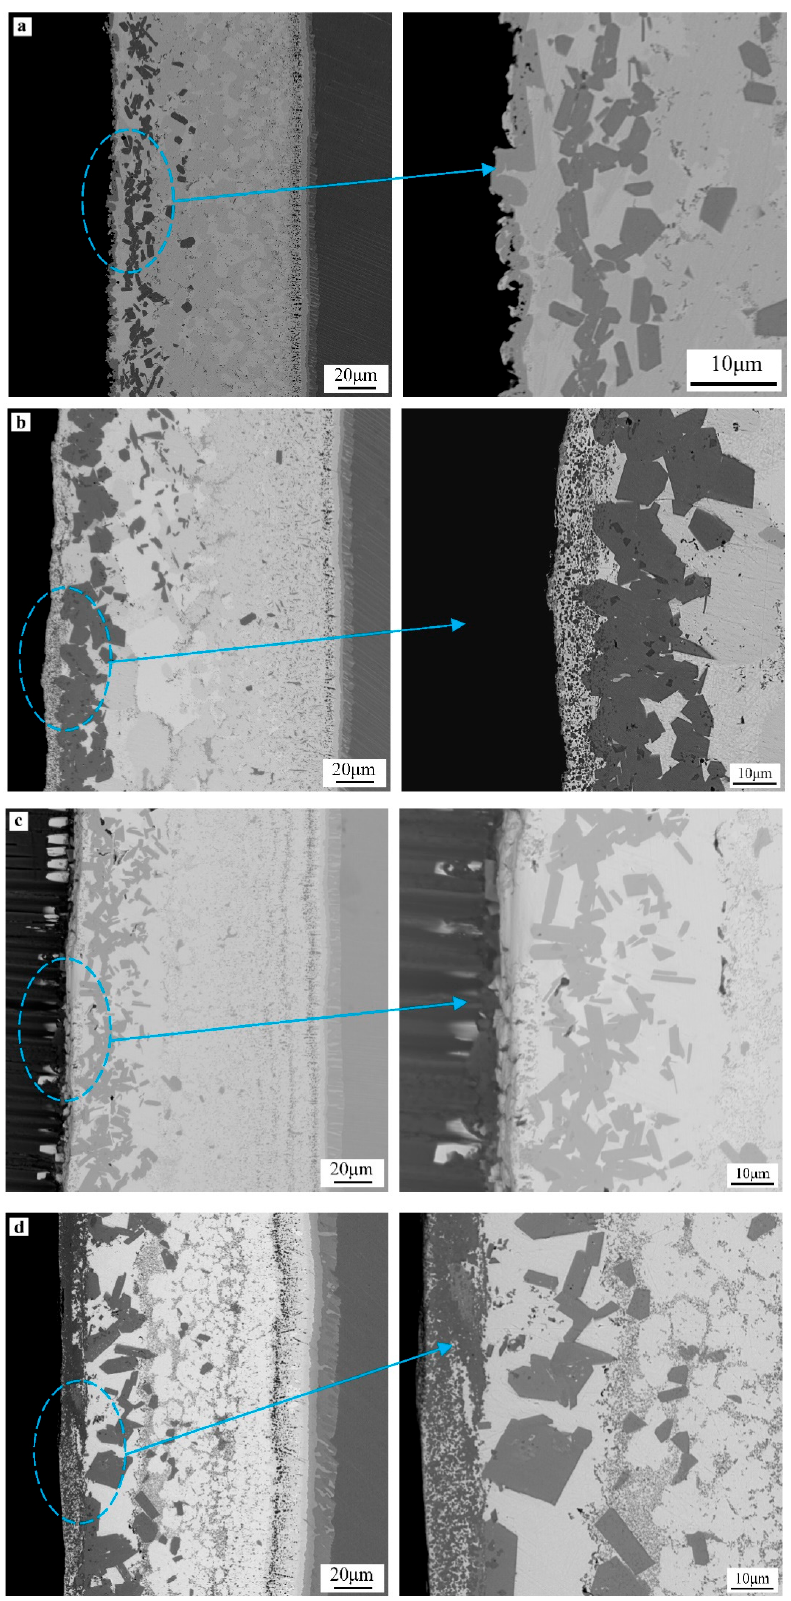
Figure 6. BSE Morphologies of brazed joint under different parameters: ( a ) 1030 ◦ C/20 min, ( b ) 1060 ◦ C/20 min, ( c ) 1090 ◦ C/20 min, ( d ) 1120 ◦ C/20